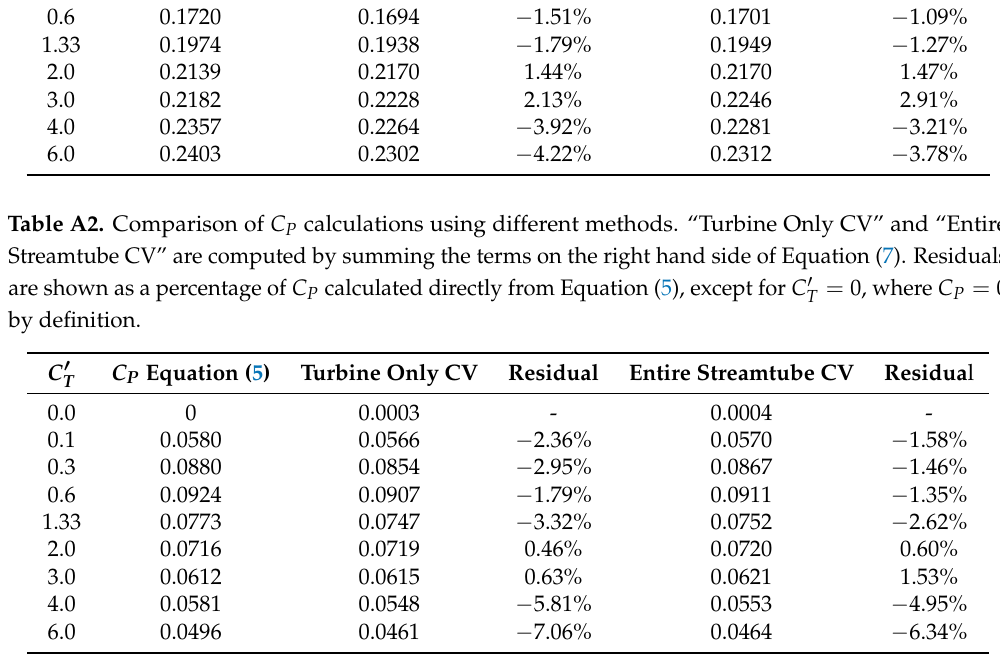
= 0, where C = 0 T T